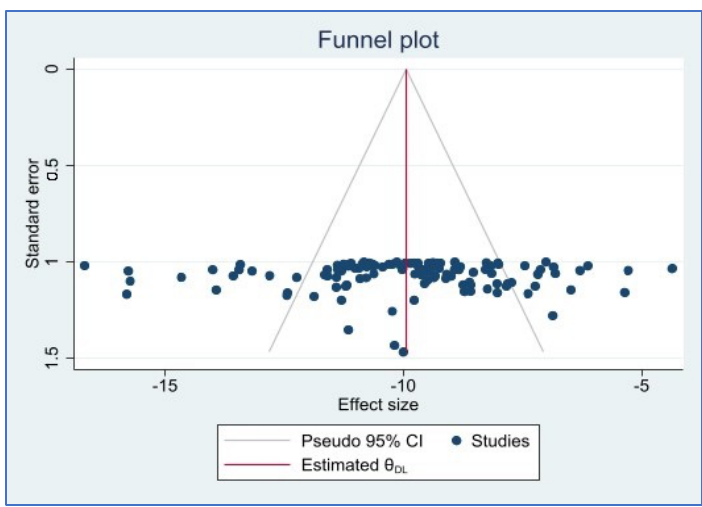
Figure 6. Funnel plot with pseudo 95% confidence limits indicating publication bias. Table 6. Egger ’s test for examining publication